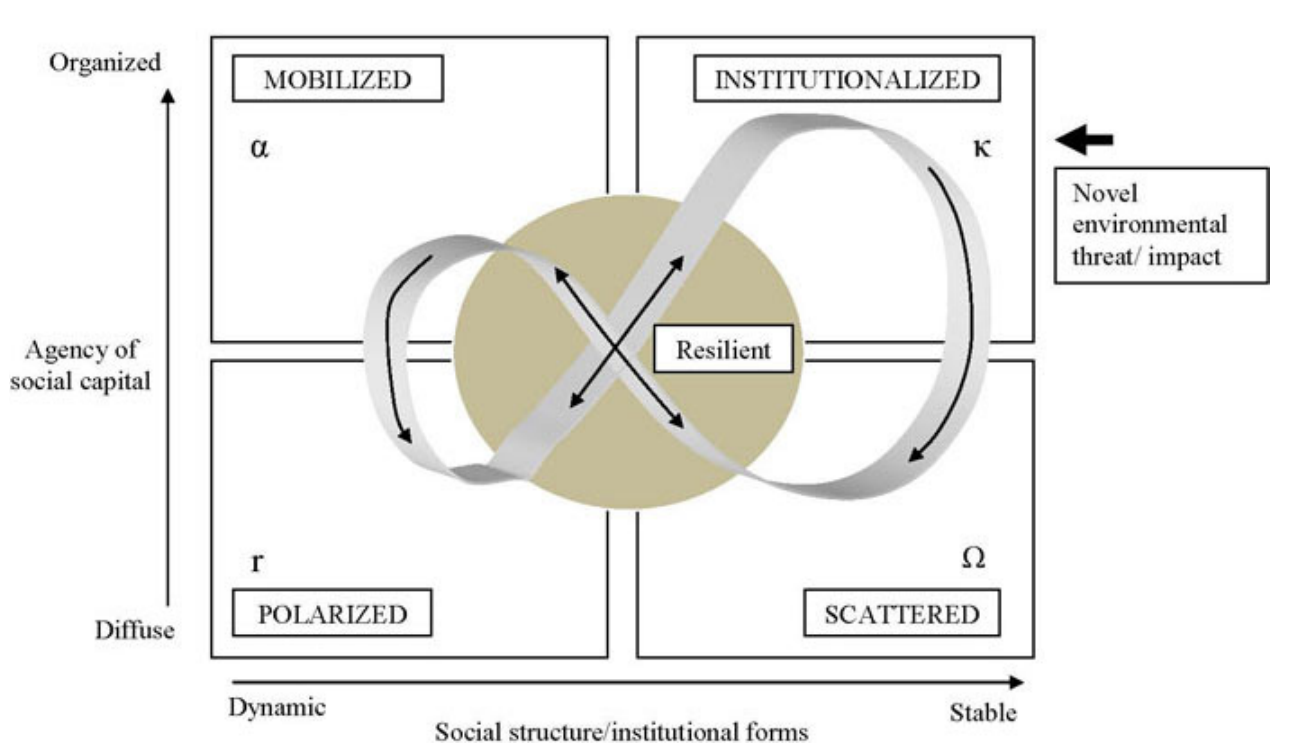
Fig. 1 . Regime transitions (based on Scheffer et al.